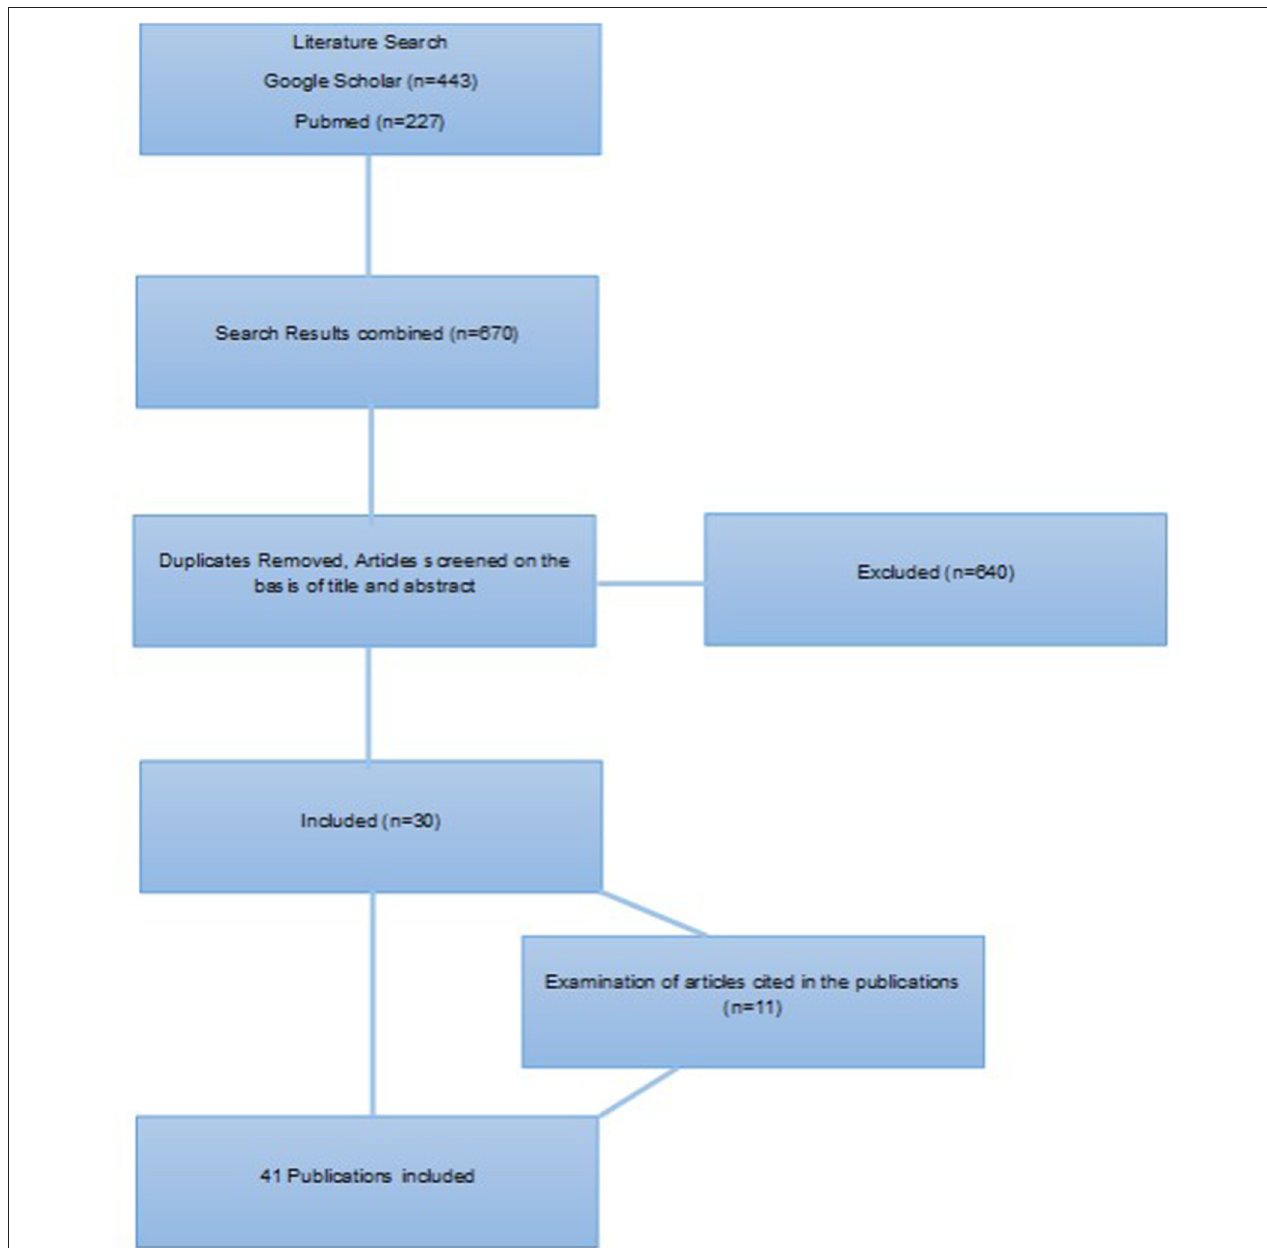
FIGURE 1 | Flowchart of study